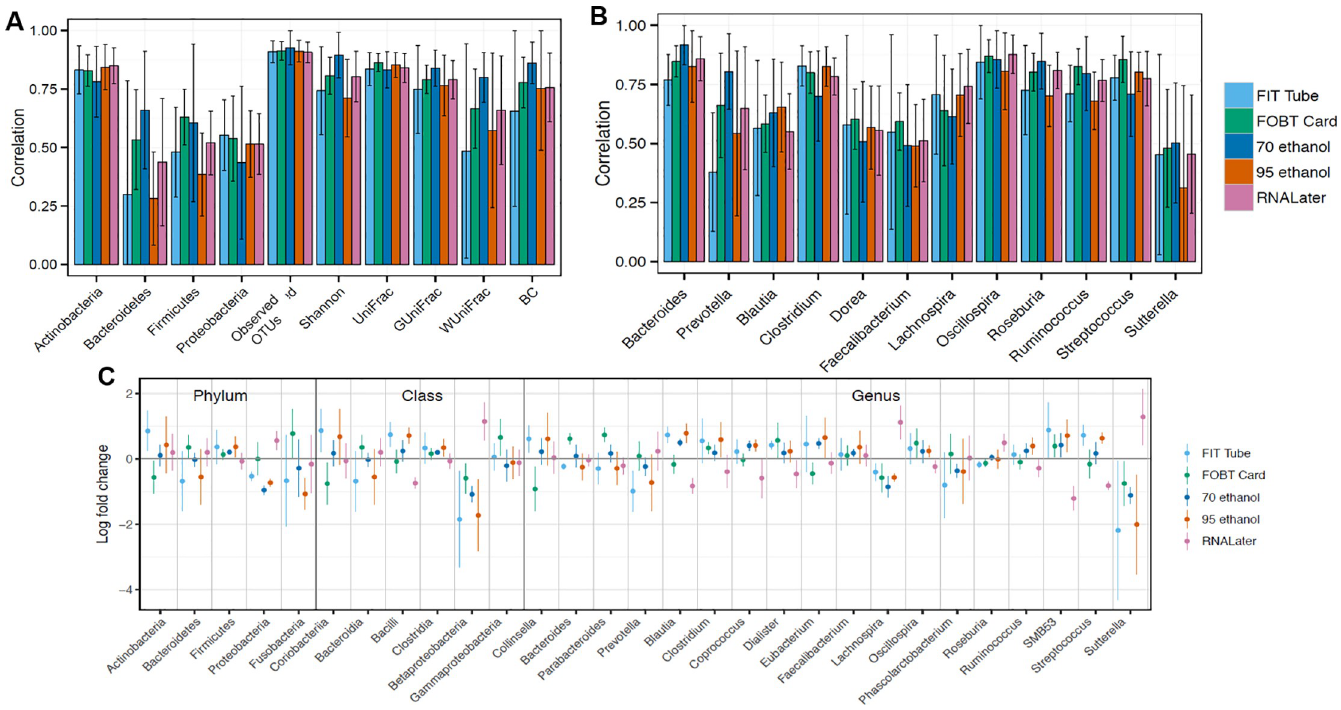
Fig 5. Meta-analyzed SCCs and log-fold changes based on random effects model for accuracy of each collection method compared to no-solution samples frozen on day-0 (the gold standard) among 132 participants in five studies (Mayo 1-Knight lab, Mayo 1-Mayo lab, Mayo 2, Bangladesh, and Colorado) with fecal samples collected using six different methods. SCCs are based on ten microbial composition metrics (panel A; square root transformed abundance of four phyla, two alpha diversity metrics [number of observed OTUs and Shannon index] and four beta diversity metrics [unweighted UniFrac, generalized UniFrac, weighted UniFrac, and Bray-Curtis distance]), and square root transformed select bacterial genera (panel B) with prevalence in the population > 80% and a mean relative abundance > 0.2%. Log-fold changes in relative abundance from day-0 (panel C) are based on select taxa with prevalence > 50% and a mean read count > 10. All error bars represent 95% CIs. Abbreviations : BC , Bray-Curtis distance; FIT , fecal immunochemical test tubes; FOBT , fecal occult blood test cards; FTA , Flinders Technology Associates cards; GUniFrac , generalized UniFrac distance; SCC , Spearman correlation coefficient; UniFrac , unweighted UniFrac distance; WUnifrac distance , weighted UniFrac distance .